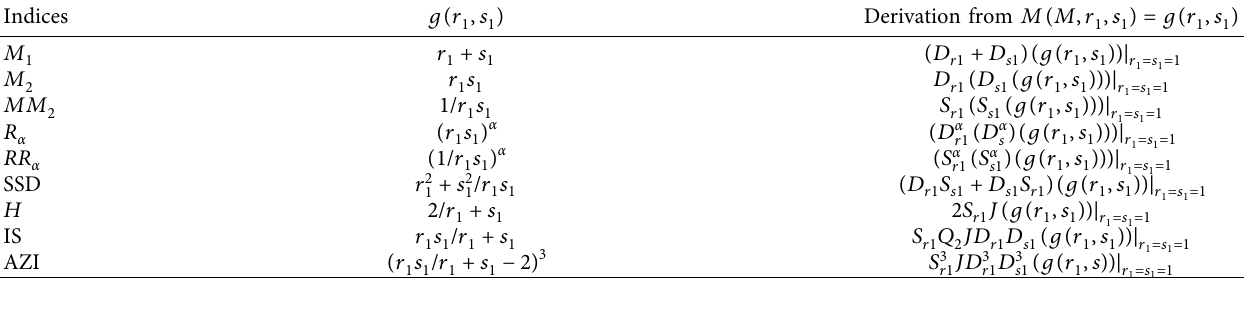
Table 1: Derivation for M-polynomials.